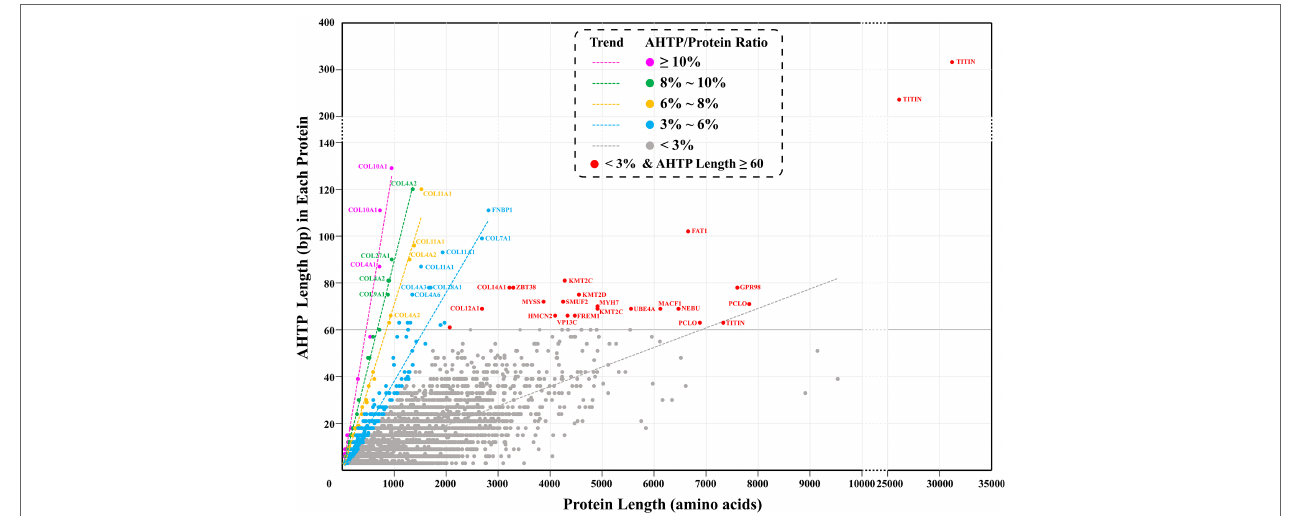
FIGURE 2 | AHTP-rich proteins in the lined seahorse. “AHTP/Protein ratio” means the ratio of the total length of AHTPs in a specific protein to the length of this protein. “Trend” shows the trendline of each group. Each dot represents a protein, and the pink, green, yellow, blue, and gray ones refer to proteins with an AHTP/ protein ratio of ≥10, 8–10%, 6–8%, 3–6%, and <3%, respectively. Red dots mark those proteins with an AHTP/protein ratio of less than 3% but containing AHTPs with a total length of more than 60 bp.